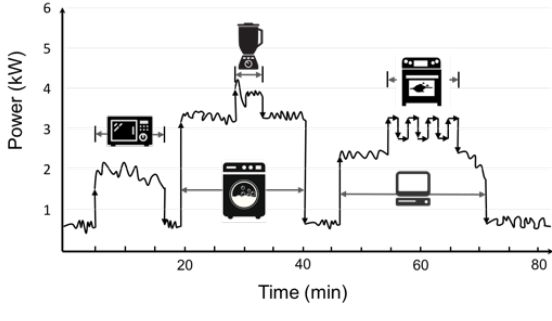
Figure 11. Disaggregation using non-intrusive load monitoring (NILM) (adapted from